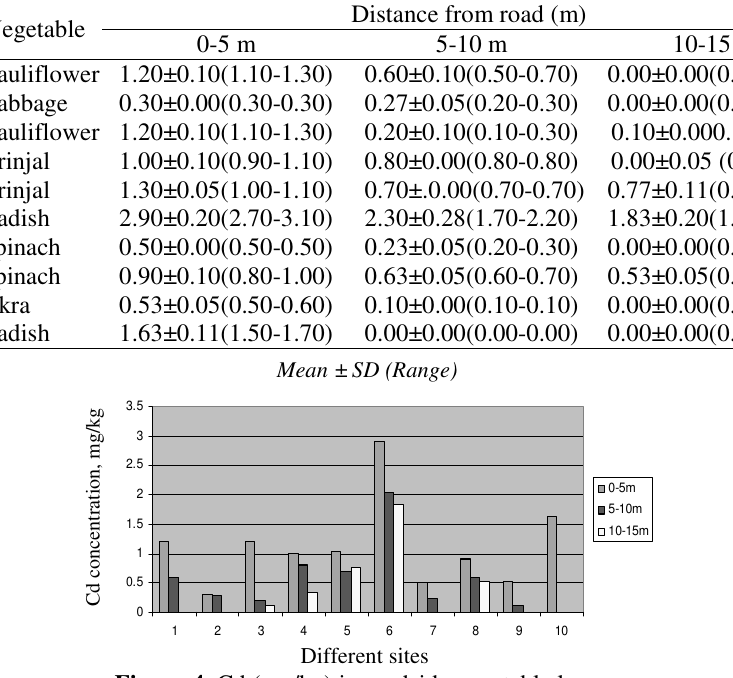
Table 5. Cadmium (mg/kg) in vegetable leaves of selected sites